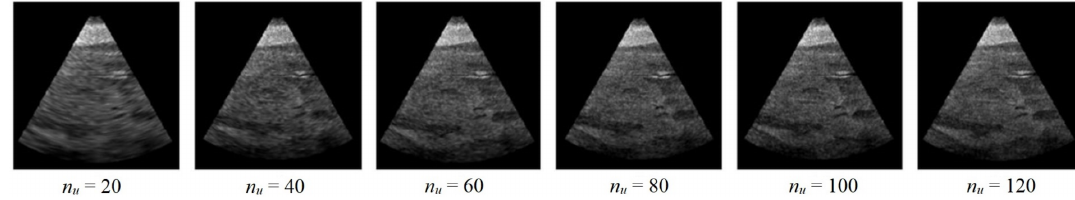
Figure 11. Synthetic images generated using radial polar sampling with a coarse to fine variation of lateral resolution parameter n .